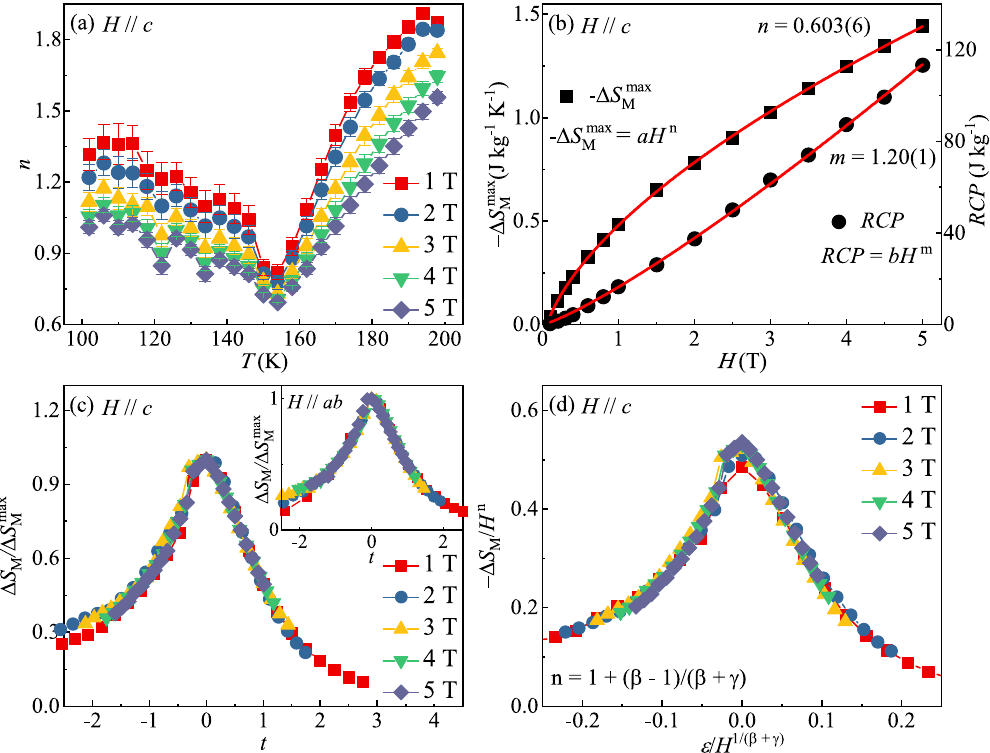
Figure 4. ( a ) Temperature dependence of n in various fields. ( b ) Field dependence of the maximum magnetic entropy change −Δ S Mmax and the relative cooling power RCP with power law fitting in red solid lines. ( c ) The normalized Δ S M as a function of the rescaled temperature t with out-of-plane field and in-plane field (inset). ( d ) Scaling plot based on the critical exponents β = 0.372 and γ = 1.265 14 .